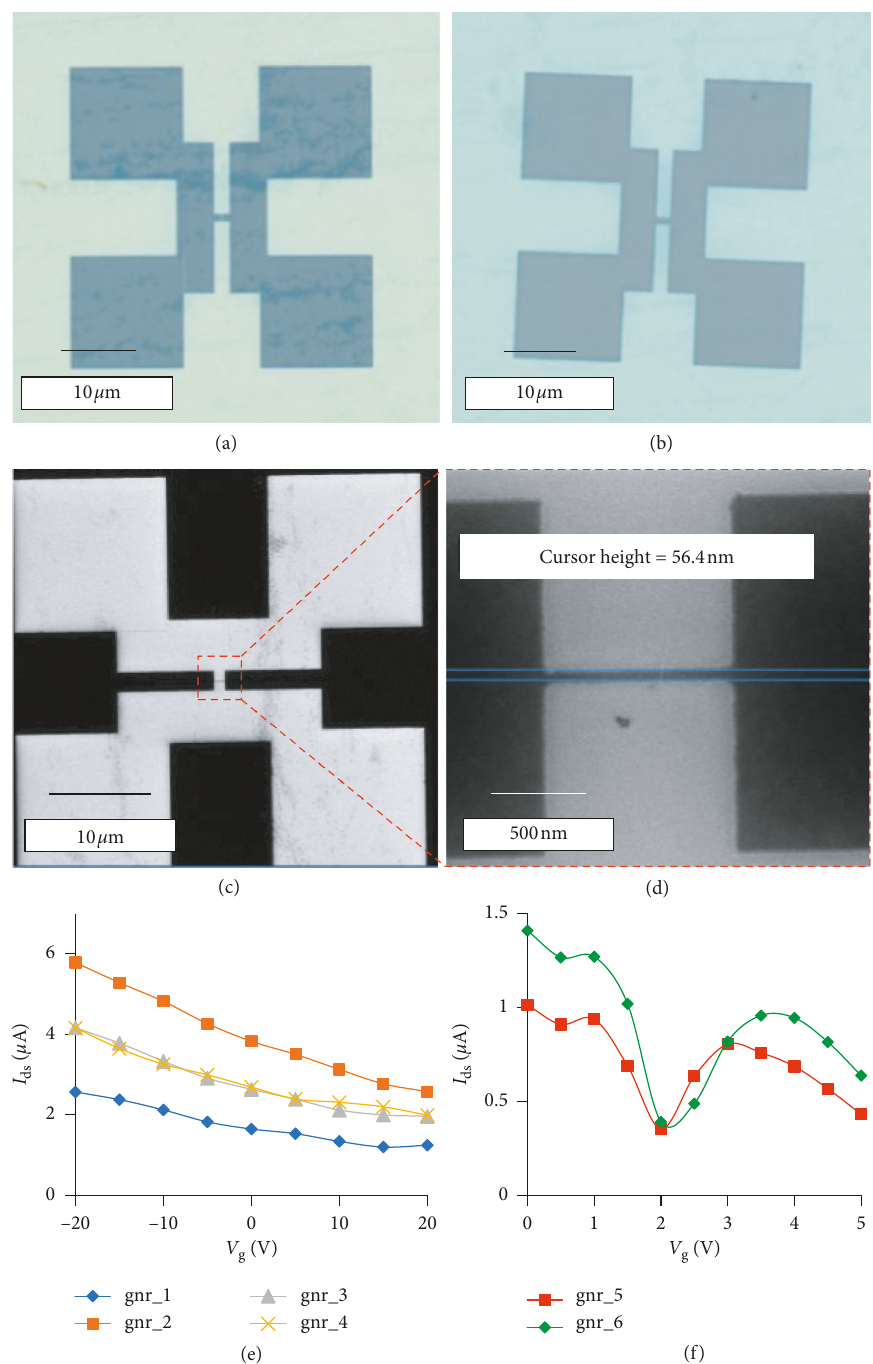
Figure 5: PMMA ribbon ( ∼ 56 nm width) patterns on graphene/silicon dioxide (a) before and (b, c, d) after exposure to oxygen plasma (8 Watts, 30mTorr, 1sccm, 2 minutes). (a, b) Light microscope images. (c, d) Scanning electron microscope (SEM) images. Three-terminal electrical measurements ( I ds V g ) are performed in different graphene nanoribbon (“gnr”) devices in (e) air conditions and in (f) distilled water with a semiconductor analyzer. A backside gate electrode is used for measurements in air and a top gate electrode for measurements in −